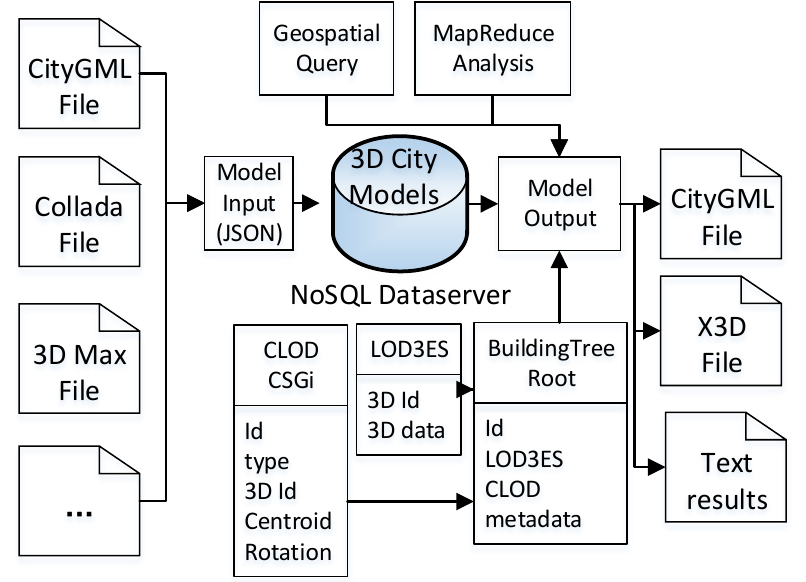
Figure 7. 3D city model management framework.